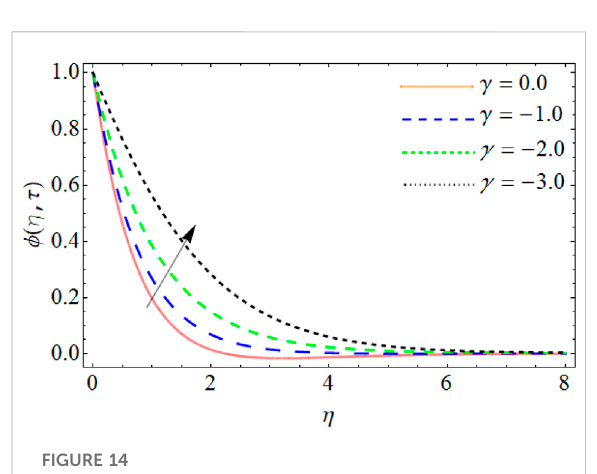
FIGURE 17 Mass outlines ϕ ( η , τ ) versus Soret number Sr